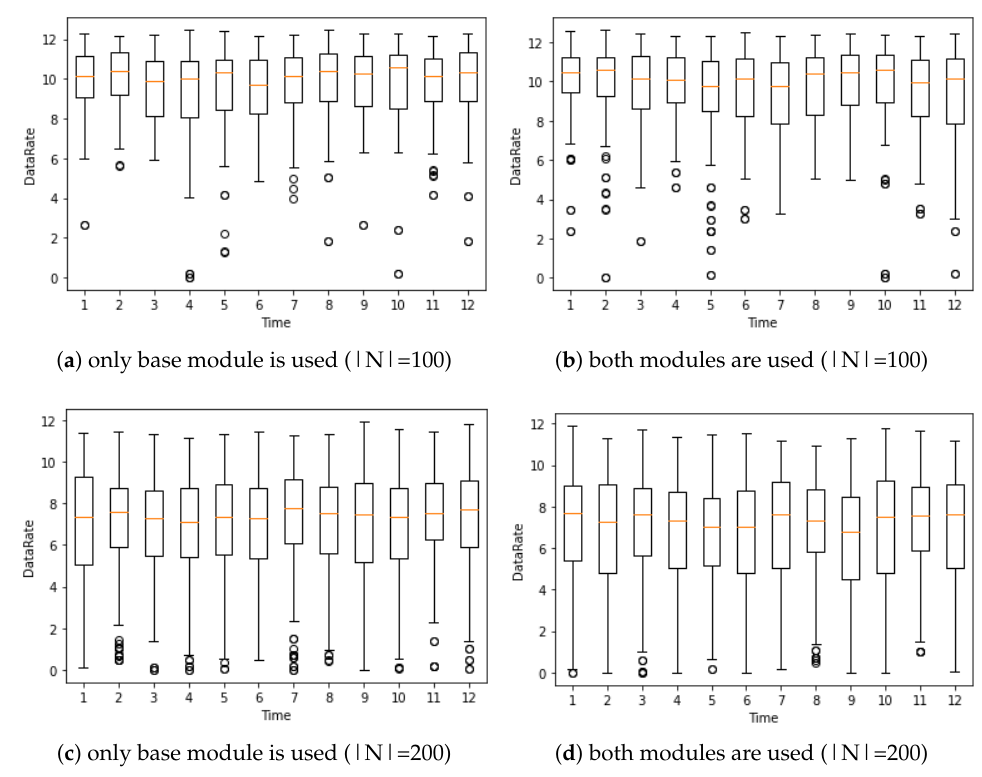
Figure 9. Validity of the adaptive